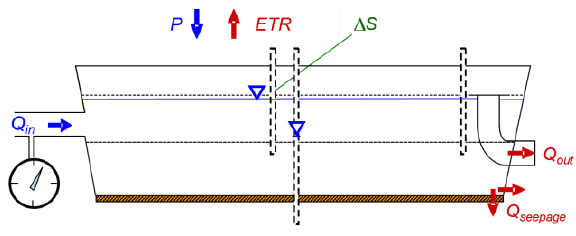
Figure 3. Water balance components. Blue: water inputs ( P = precipitation, Q losses ( ETR = evapotranspiration, Q Q = outflow); green: plus/minus change in out storage (∆ S